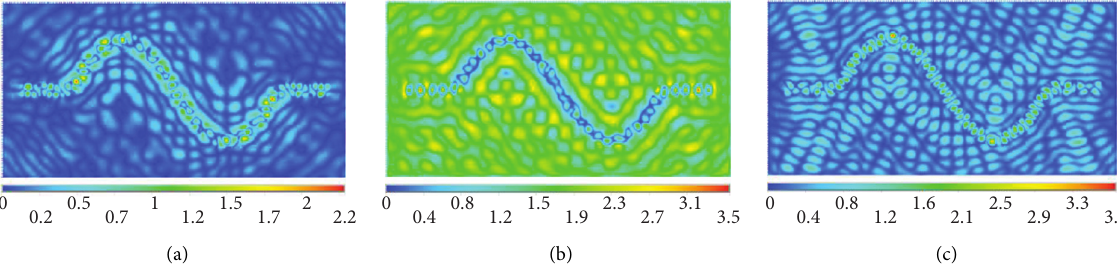
Figure 25: SH wave incident ( f � 4.0Hz, H � 100m, C